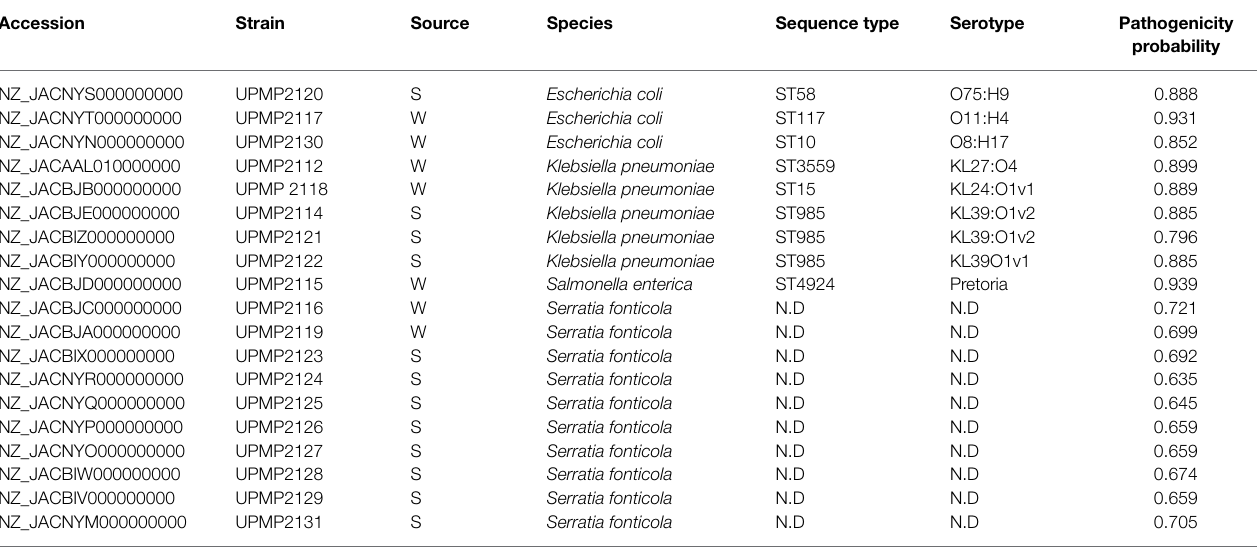
TABLE 2 | In silico multi-locus sequence typing (MLST) analysis, predicted serotypes, and pathogenicity probability of Enterobacterales isolated from irrigation water and spinach throughout production from farm to retail.